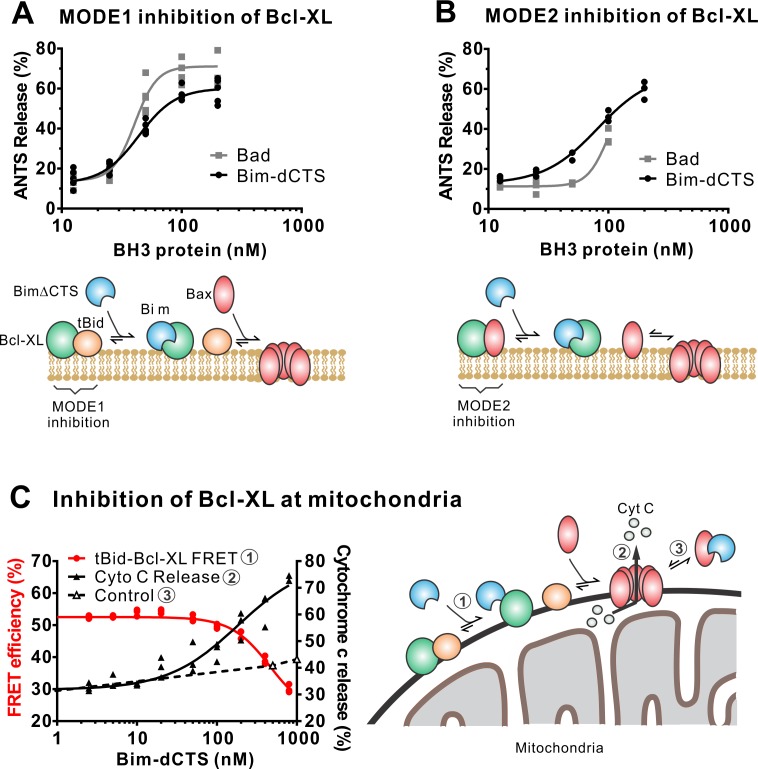
The Bim CTS is not required to inhibit Bcl-XL.(A–B) BimL-dCTS and Bad release tBid (A) or Bax (B) from Bcl-XL. 20 nM tBid (A) or tBidmt1 (B) a protein that activates Bax but does not bind Bcl-XL, were incubated with 100 nM Bax, 40 nM Bcl-XL, 0.04 mg/mL ANTS/DPX liposomes, and the indicated amounts of either Bad or BimL-dCTS. Liposome permeabilization was assessed after incubation at 37 °C for 3 hr by measuring the increase in fluorescence due to ANTS/DPX release. Cartoons indicate the interactions measured, BimL (blue), Bax (red), tBid (orange), Bcl-XL (green), and membranes (tan). (C) BimL-dCTS displaced tBid from Bcl-XL and permeabilized mitochondria. Mitochondria were incubated with Bcl-XL (40 nM), tBid (20 nM), Bax (100 nM) and mitochondria. Increasing concentrations of BimL-dCTS were added and displacement of tBid from Bcl-XL was measured by FRET. Mitochondria were then pelleted and cytochrome c release measured by western blotting. Control reactions containing only Bax and BimL-dCTS did not result in cytochrome c release (dotted line). Individual points are shown for three independent replicates. Not all points are visible due to overlap. The adjacent cartoon indicates the interactions measured.Figure 5—source data 1.Source data demonstrating that recombinant BimL-dCTS indirectly activates Bax through inhibition of Bcl_XL.